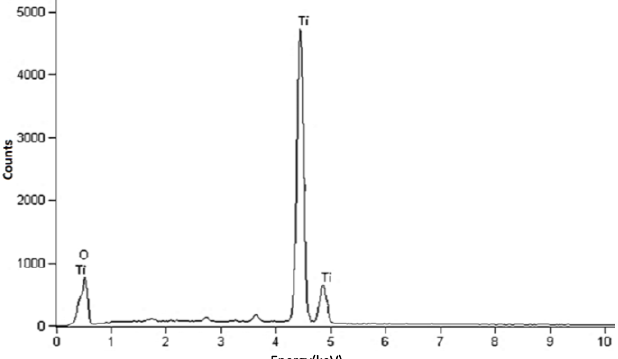
Figure 3. Energy dispersive X-ray spectroscopy (EDX) spectrum of TiO 2 nanoparticles calcined at temperature of 600 °C.